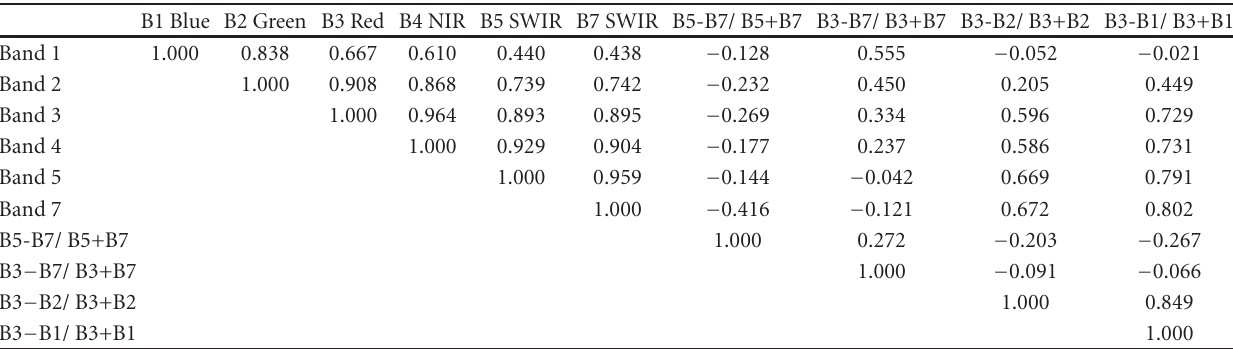
Table 1: Correlation matrix for six spectral bands and four normalized indices calculated from a 24 Feb 2002 Landsat ETM+ image. Normalized indices were calculated using ETM+ spectral bands: gypsic index [(B5 − B7)/(B5+B7)] from [16] and iron oxide index [(B3 − B1)/(B3+B1)] from ERDAS Imagine (v.9.3, ERDAS, Inc., Norcross, Ga, USA) software.